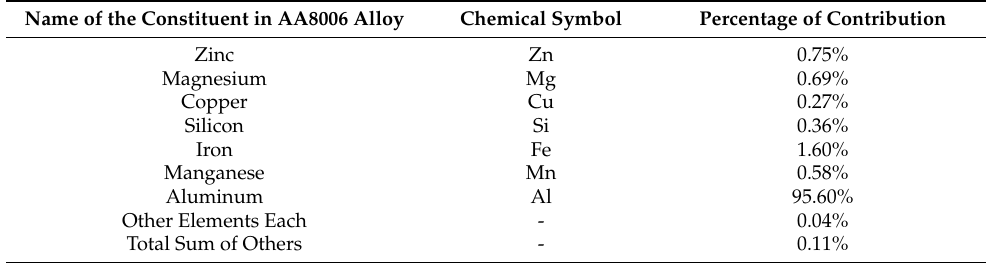
Table 1. Constituents of the AA8006